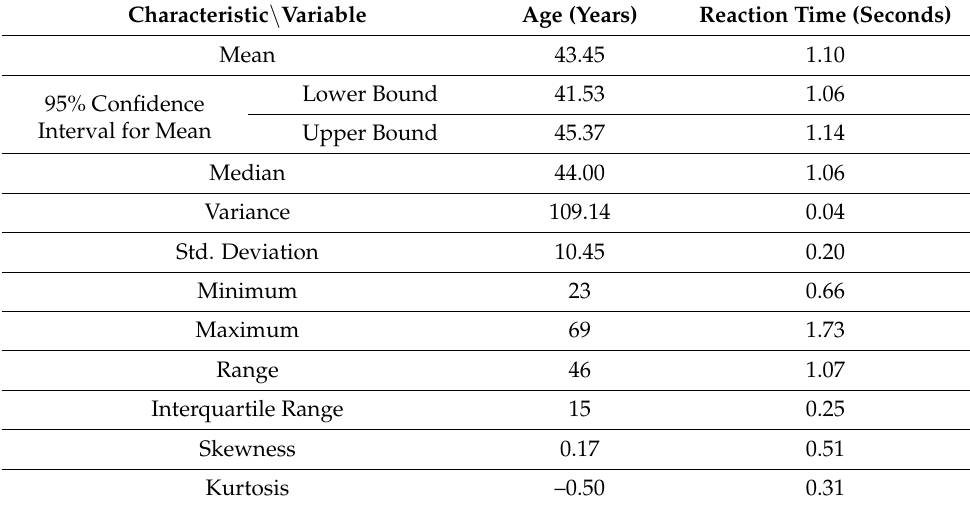
Table 2. Descriptive characteristics of the variables used in the study.